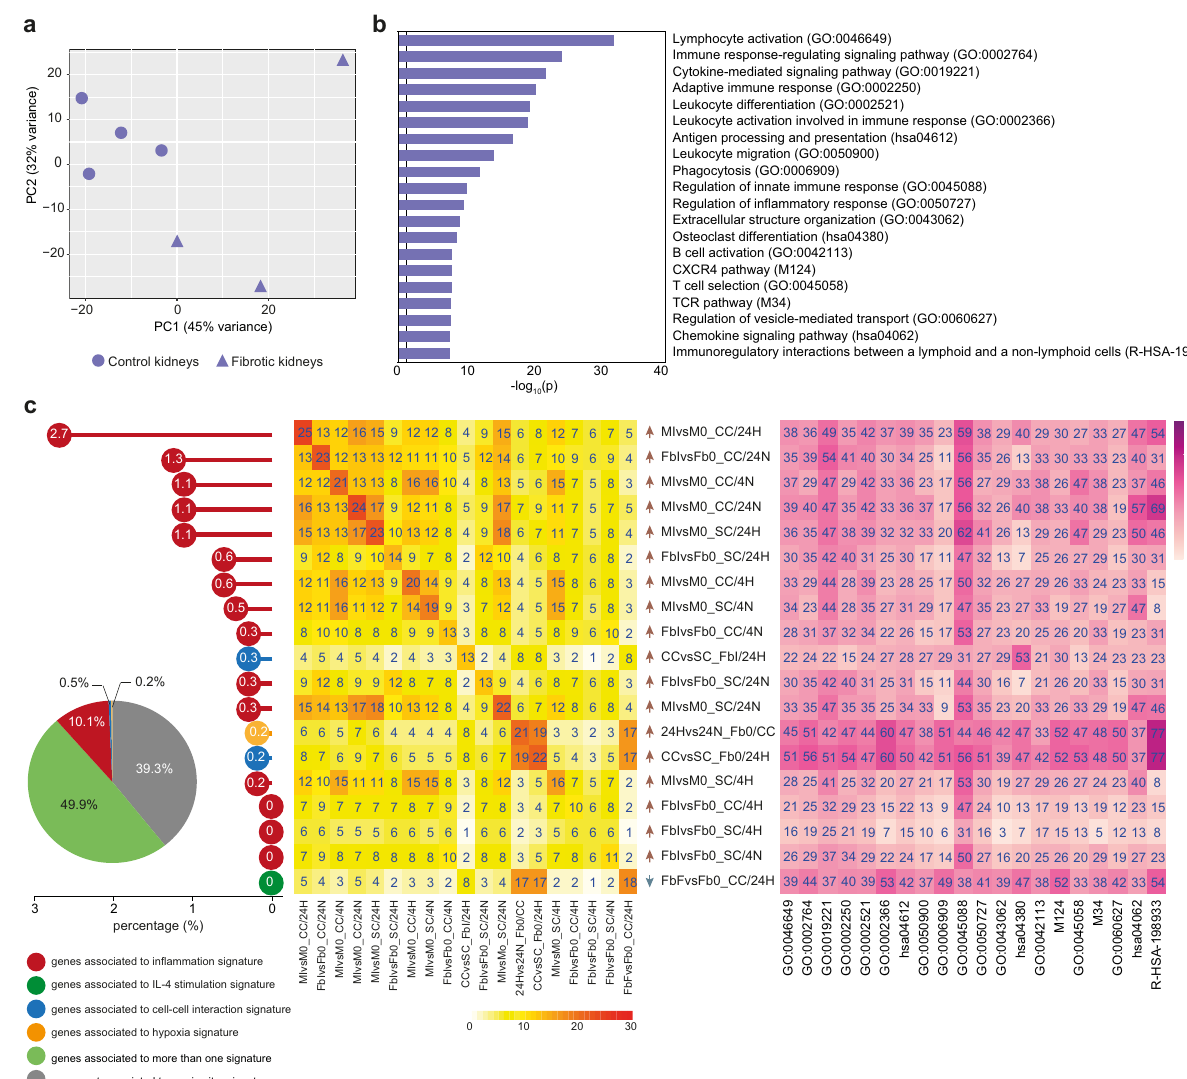
Fig. 7 | Gene overlap analysis of ex vivo tubulointerstitial area from fi brotic kidneys with in vitro signatures. a PCA of ex vivo interstitium samples. Triangles indicate fi brotic kidneys, dots control kidneys. b Bar graph reports pathways sig- ni fi cantly enriched (log 10 ( p -value) ≥ 1.3) in fi brotic vs control interstitium samples as calculated by Metascape software (for statistical type of analysis see ref.45). c Overlap analysis was performed comparing DEGs of ex vivo fi brotic vs control interstitium with DEGs of each in vitro comparison (which de fi ned 78 corre- sponding signatures). Piechart reveals that 49.9% ofex vivo signatureisexplained by at least one in vitro signature (in light green); 10.8% is speci fi cally explained by only one in vitro signature and different colors are referred to the discriminating variable: in fl ammation inred,IL-4 stimulation ingreen, cell-cell interactionin blue, hypoxia in yellow. The remaining 39.3% of the ex vivo interstitium signature (633 genes)isnotexplainedbyinvitromodel(ingray).Dotchartreportsonthevertical